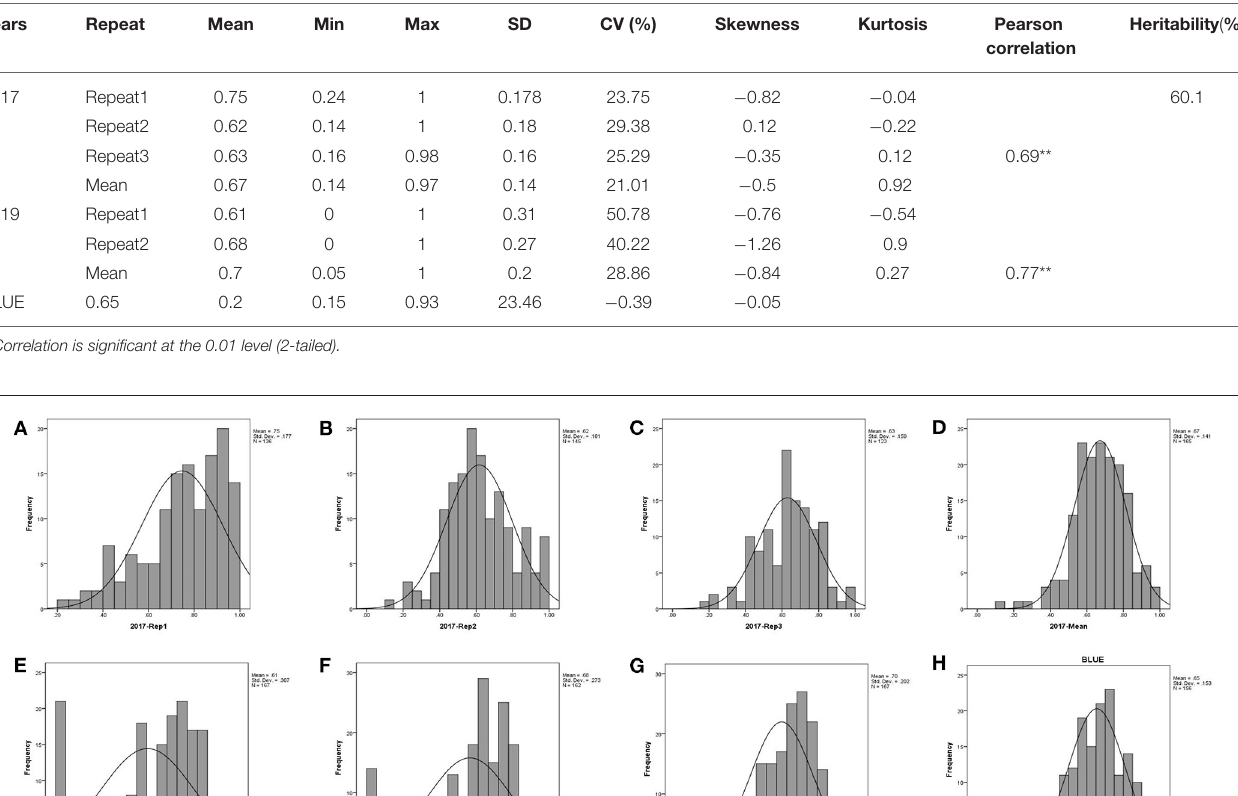
TABLE 1 | Statistical summary of phenotypes of 165 maize inbred lines.